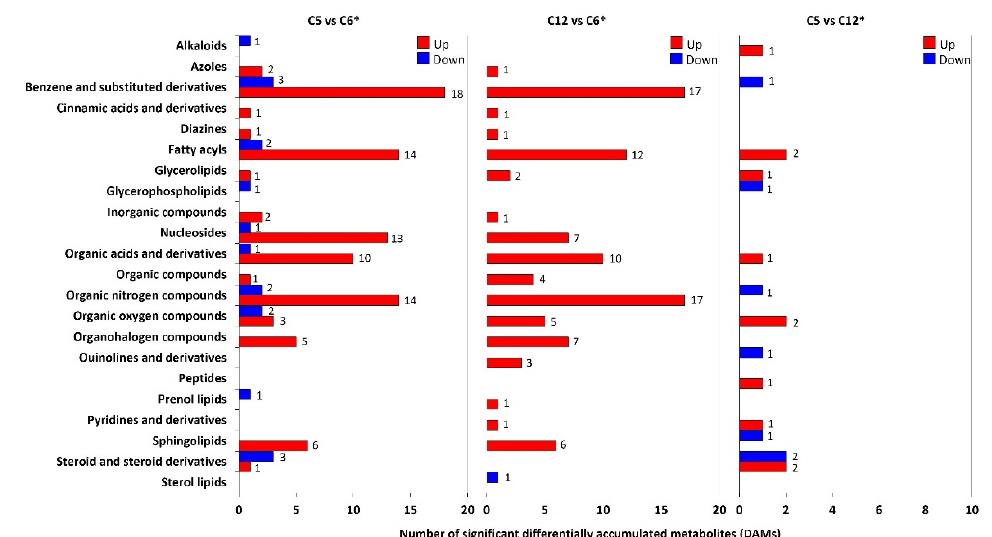
Figure 2. The significant differentially accumulated metabolites (DAMs) across pairwise comparison sets of the cultures using different carbon sources. The bar chart shows the number of significant DAMs in each set of pairwise comparisons. The x -axis represents the number of significant DAMs, and the y -axis shows the known classes according to the metabolite database (Supplementary File S2). The asterisk (*) means the reference carbon source used for all possible pairwise